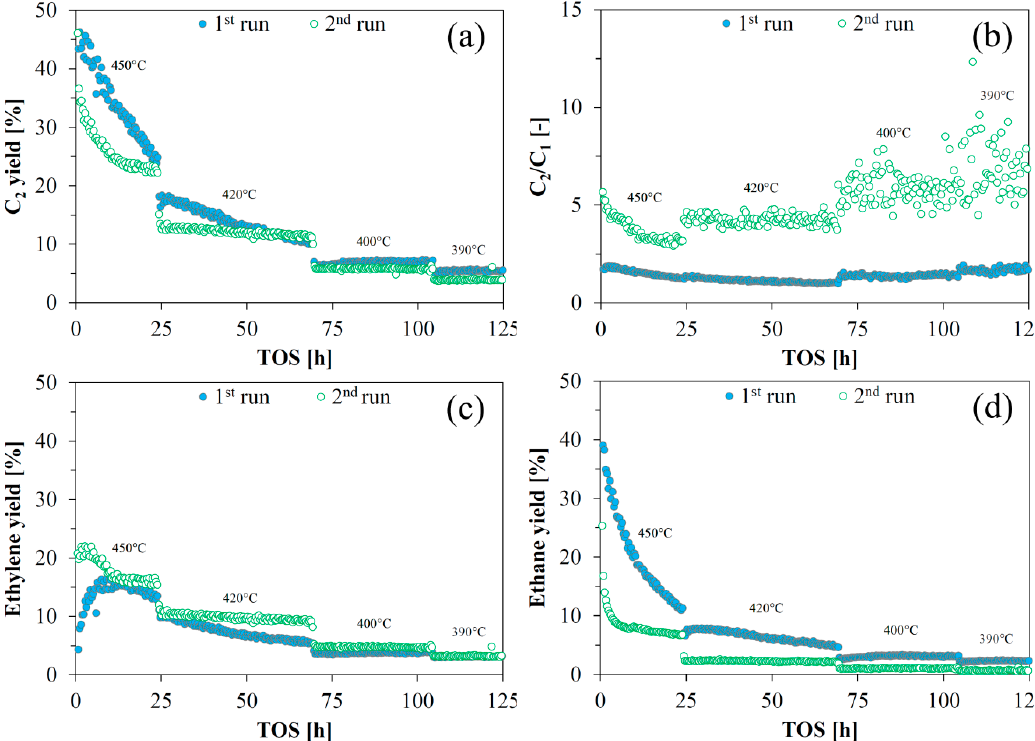
Figure 4. Carbon based ( a ) C 2 yield; ( b ) C 2 /C 1 ratio; ( c ) ethylene yield, and ( d ) ethane yield for the